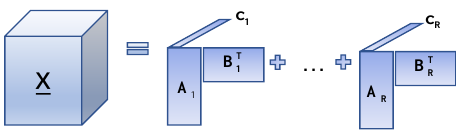
Figure 3. Block-term tensor decomposition